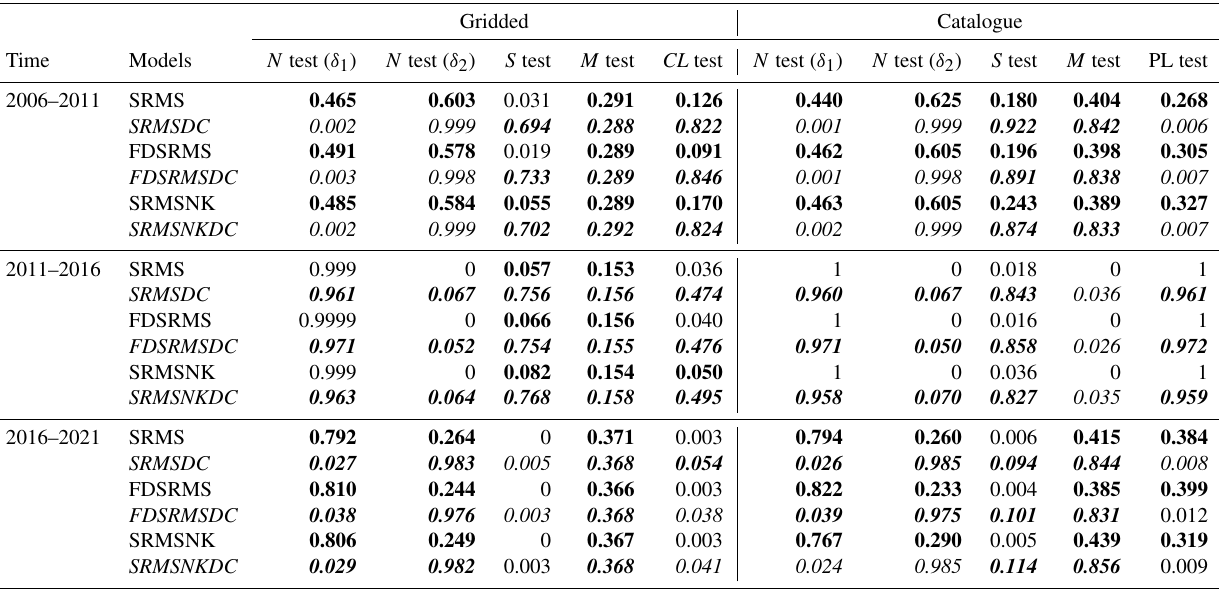
Table 2. Quantile scores for CSEP tests. Upper bounds for S , L and PL tests, lower bound for N . Bold indicates consistency with observations and italics highlight declustered